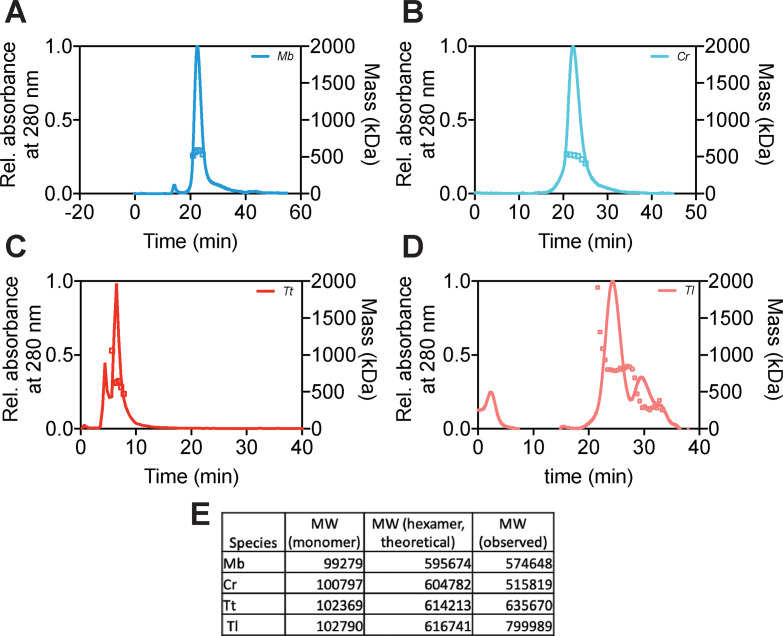
Hsp104 homologs form hexamers.(A–D) Size-exclusion chromatography coupled to multiangle light scattering (SEC-MALS) demonstrates that Hsp104 homologs form hexamers. In each panel, traces represent relative protein concentration determined by relative absorbance at 280 nm (A280) and plotted squares represent molecular weight readings determined by multiangle light scattering. (E) Comparison of theoretical molecular weights for Hsp104 hexamers to molecular weights observed by SEC-MALS.